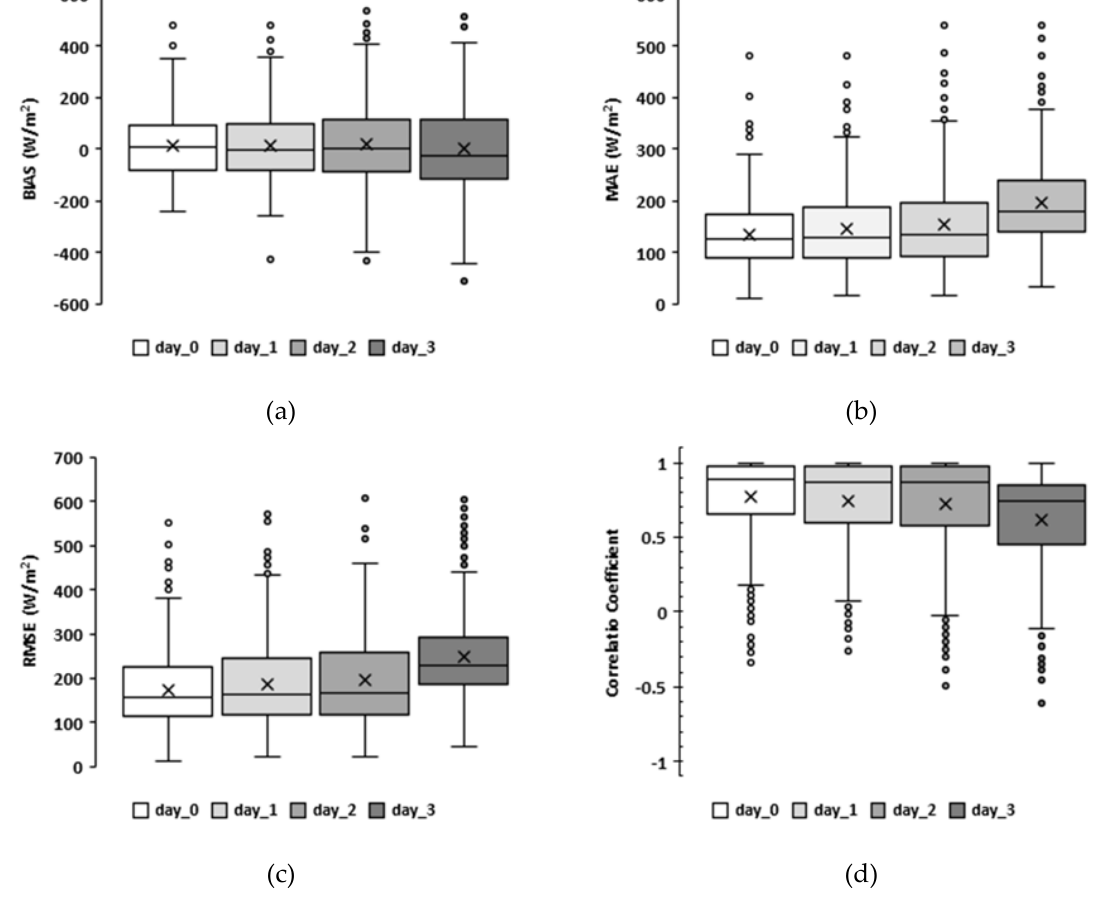
Figure 4. Boxplots of statistical indicators based on hourly values for ( a ) Mean Bias Error (MBE), ( b ) Mean Absolute Error (MAE), ( c ) Root Mean Square Error (RMSE), and ( d ) Correlation Coefficient (r), for different days ahead of forecast. The crosses represent the mean value of the sample, the horizontal solid line within the box represents the median, and the bottom and top of the boxes indicate the first and third quartiles, respectively. Boxes correspond to the Interquartile Range (IQR) where 50% of the data is located. The circles represent the outliers, and the lower and upper ends of the whiskers are the minimum and maximum values of the datasets, respectively.